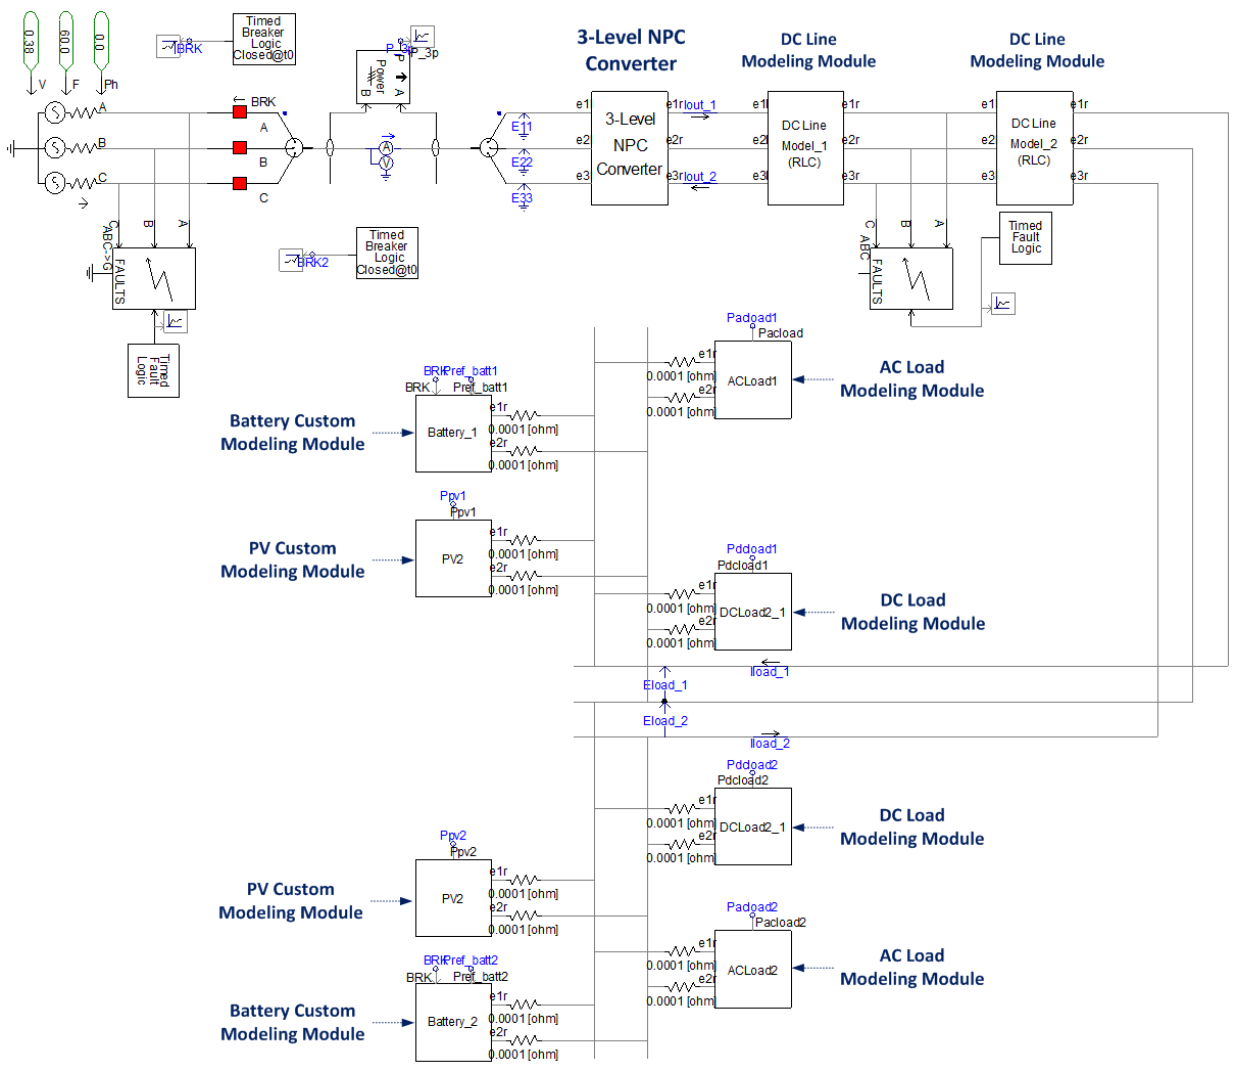
Figure 3. Power system computer aided design/electro-magnetic transient direct current (PSCAD/EMTDC) simulation model of LVDC